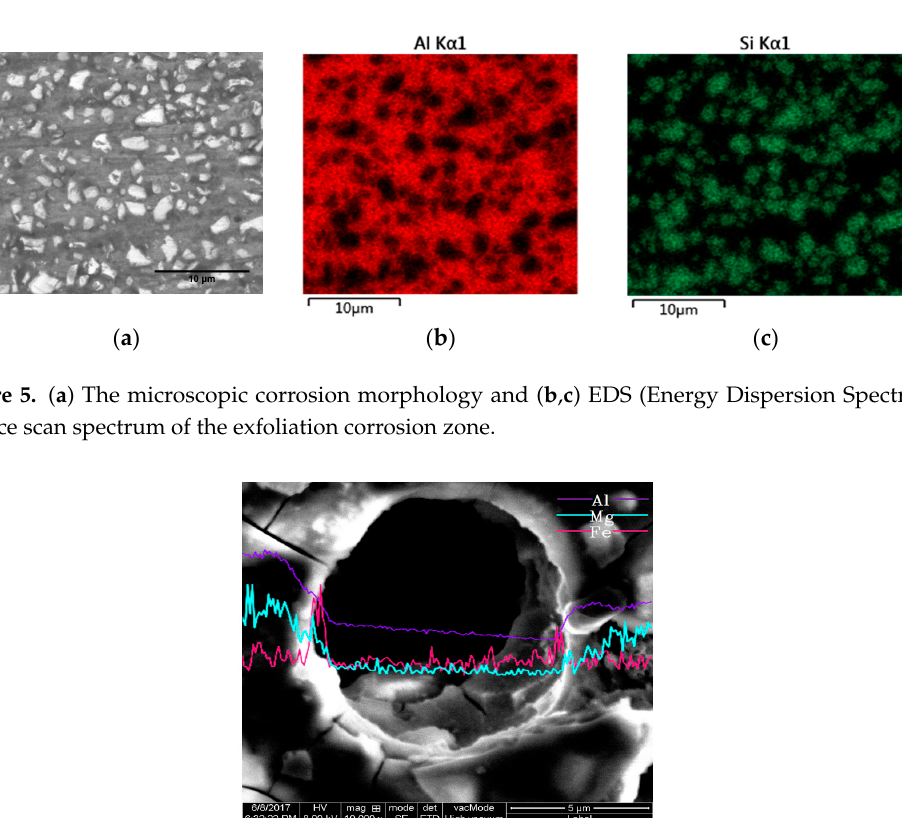
Figure 6. The microscopic corrosion morphology and EDS line scan spectrum of the pitting zone.